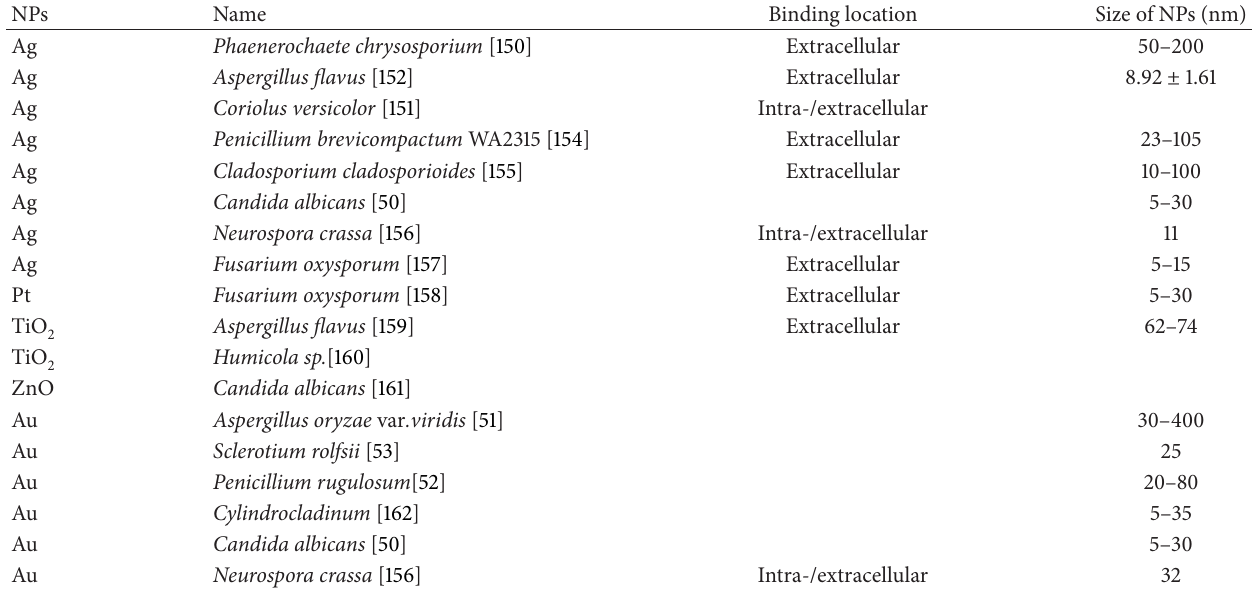
Table 4: Fungi-mediated biosynthesis of metal